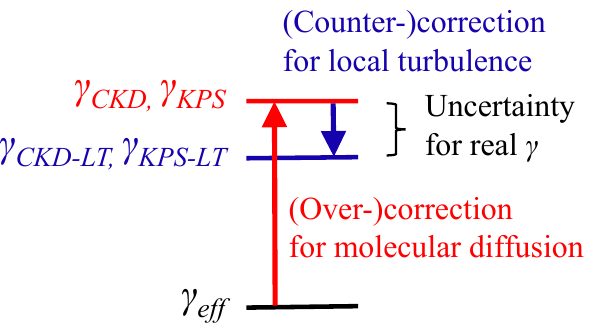
Figure 7. Schematic of different types of uptake coefficients and their divergences due to molecular diffusion and local turbulence ef- fects. The uncertainty of γ is constrained by γ CKD and γ CKD-LT , or γ KPS and γ KPS-LT . Note that the degree of the divergences among these types of uptake coefficients depends on their magnitude; i.e., for lower uptake coefficient values, no corrections are needed (see Figs. 8 and 9). Similarly, γ CKD and γ KPS , or γ CKD-LT and γ KPS-LT , may differ from each other depending on their magnitude (see Figs. 8 and 9, and Appendix C). The abbreviations and symbols are explained in Appendix A.